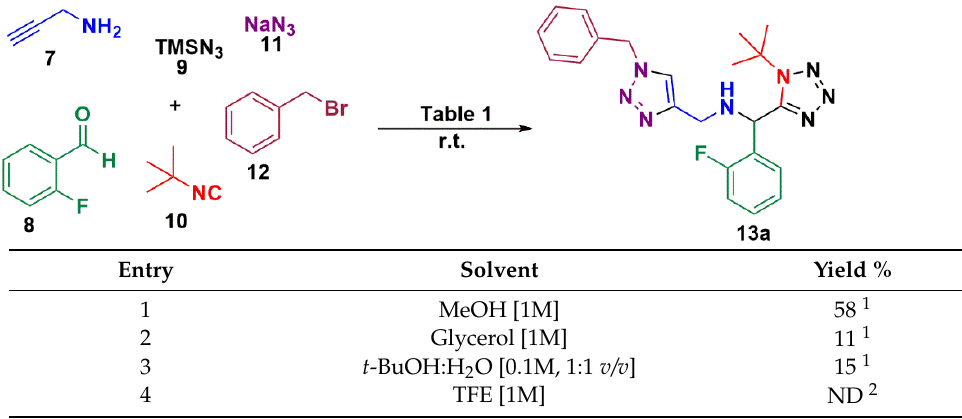
Table 1. Optimization of the one-pot six-component reaction conditions.